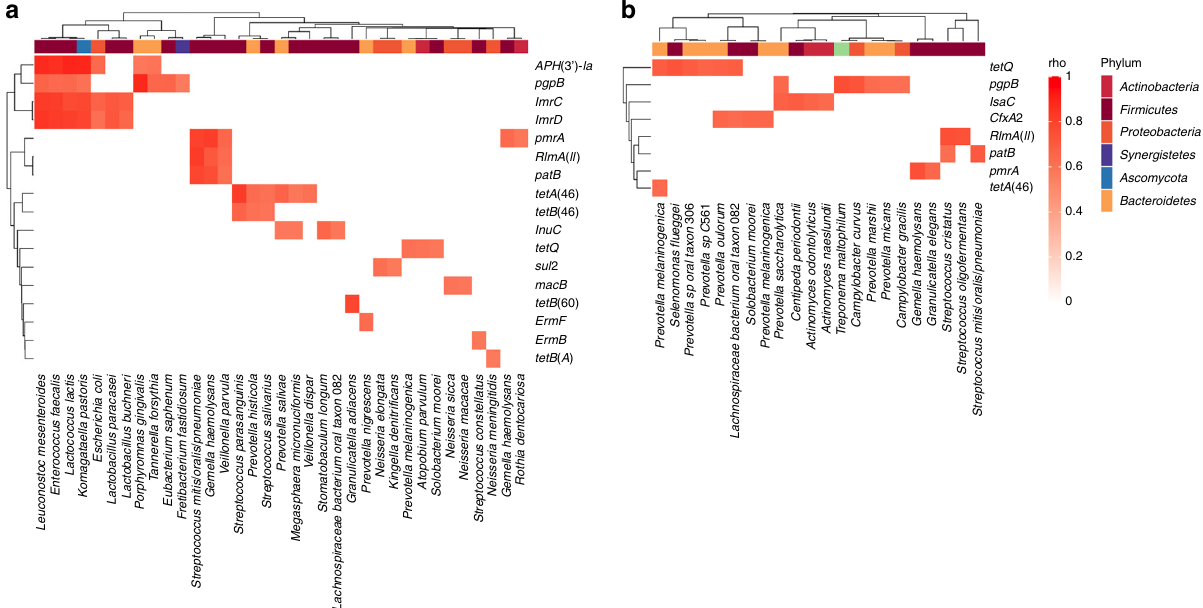
Fig. 5 Spearman ’ s correlation of ARG and species abundance from saliva samples. Each heatmap represents correlations of individuals from a China ( n = 31) and b Philippines ( n = 23). Rows and columns are clustered by hierarchical clustering of Euclidean distance. Columns are coloured by phylum. P -values are adjusted by Benjamini – Hochberg multiple test correction. Rho shown only where adjusted p -value < 0.05. Source data are provided in the Source Data fi